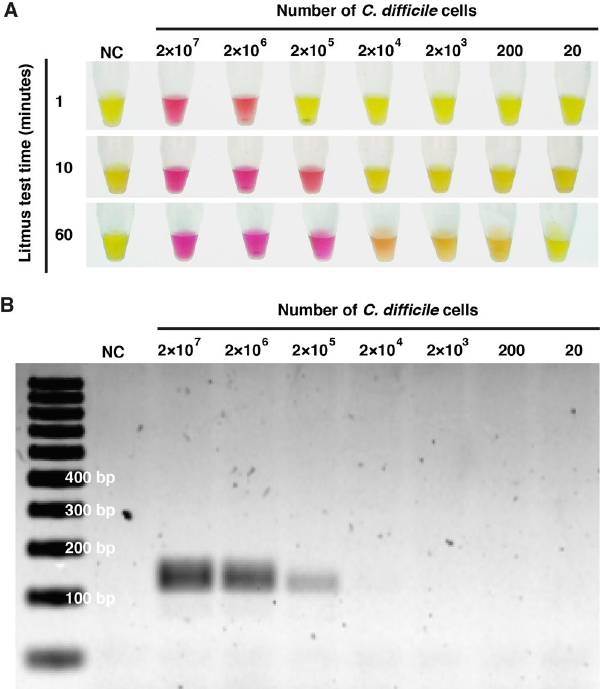
Figure 3. Sensitivity of PCR-litmus test for C. difficile detection. 28 cycles of PCR was performed with genome DNA prepared from various numbers of C. difficile cells. Strain ATCC 1803, forward primer P3 and reverse primer RP were used in this test. ( A ) Litmus test with PCR products. The photograph was taken after a signal- producing time of 1 minute (top panel), 10 minutes (middle) and 60 minutes (bottom). ( B ) Analysis of PCR products by 2% agarose gel electrophoresis.